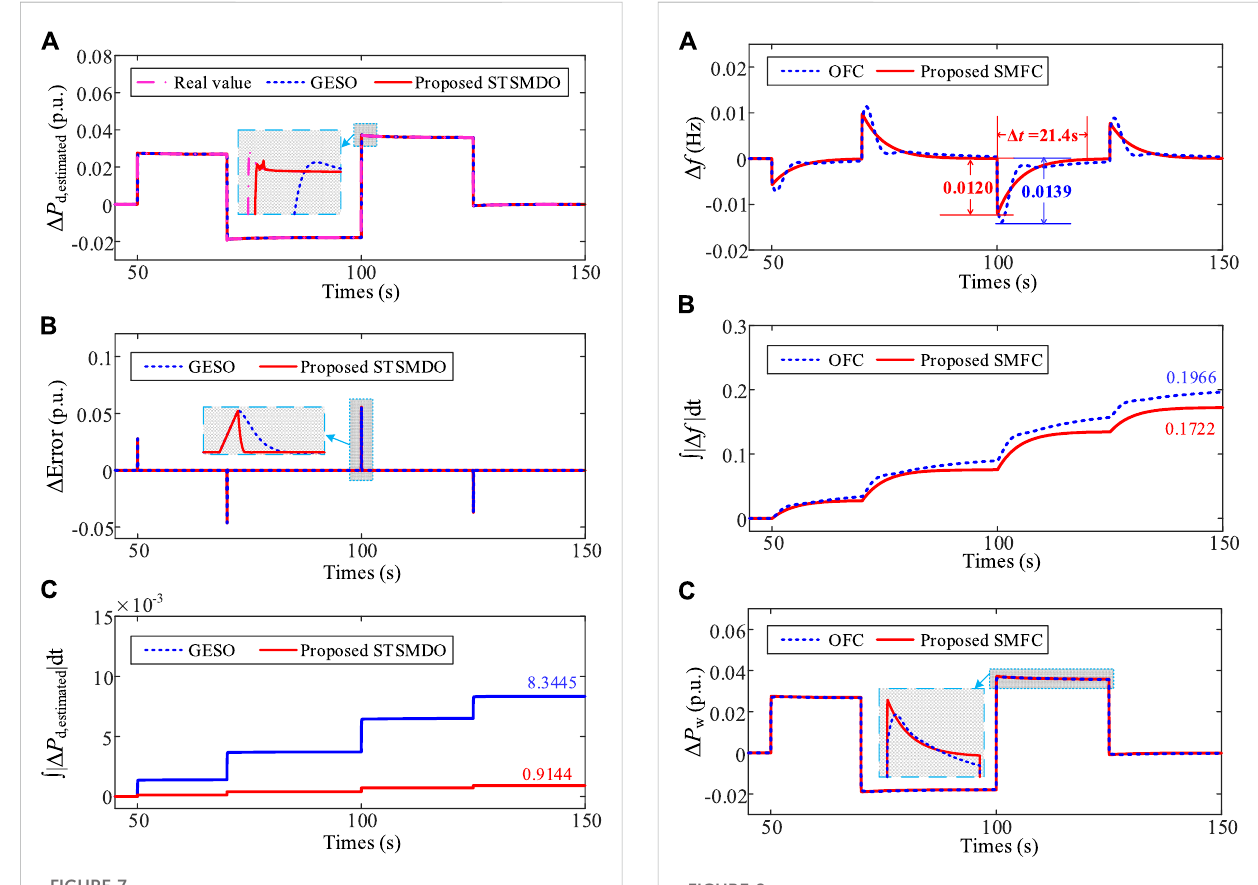
FIGURE 7 Comparison results of the disturbance observation between the STSMDOandtheGESOunderuncertainloaddisturbance. (A) Lumped disturbance estimated result. (B) Estimation error. (C) Total estimation error , | Δ P d,estimated |dt.